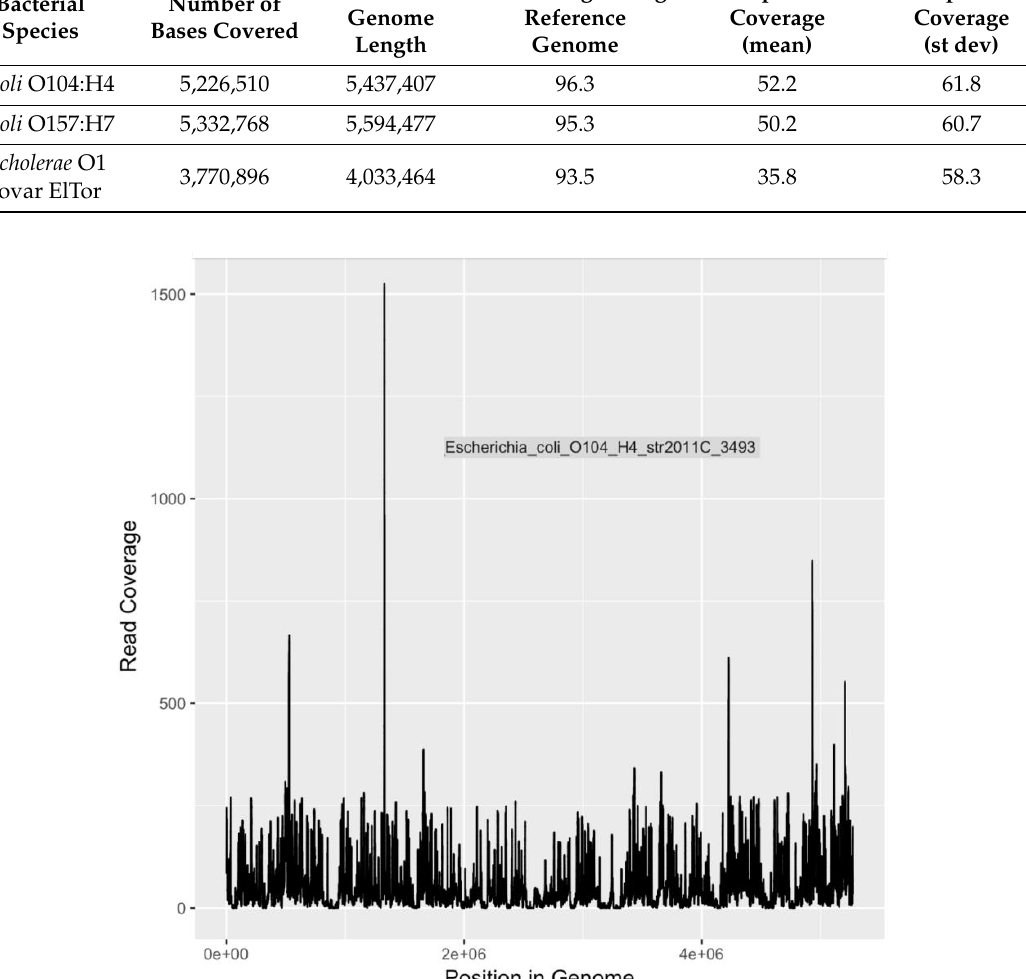
Table 8. Sequencing coverage calculations for E. coli O104:H4, E. coli O157:H7, and V. cholerae O1 biovar Eltor.